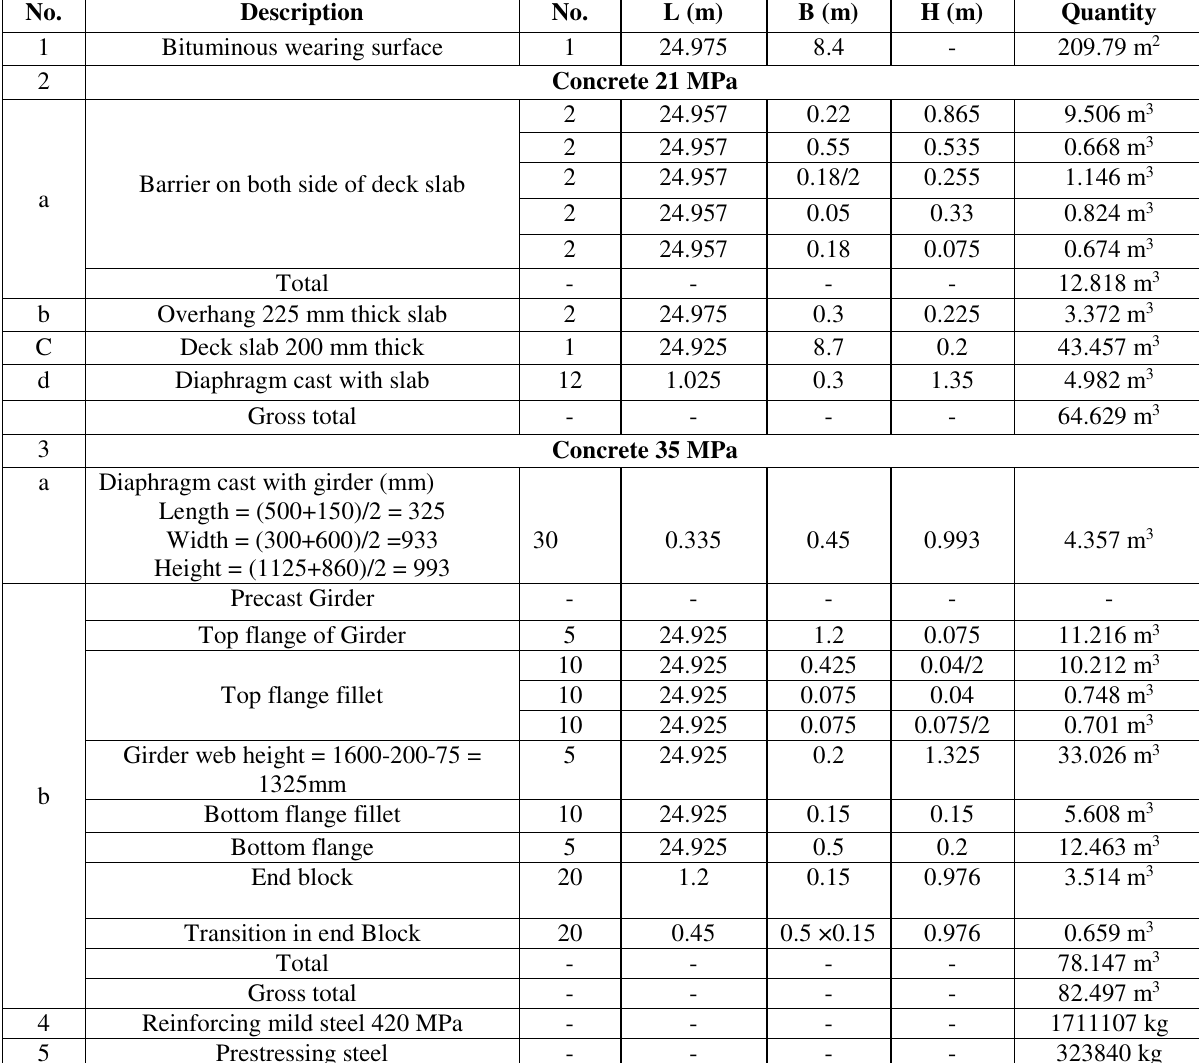
TABLE 7. BILL OF QUANTITIES FOR T BEAM BRIDGE